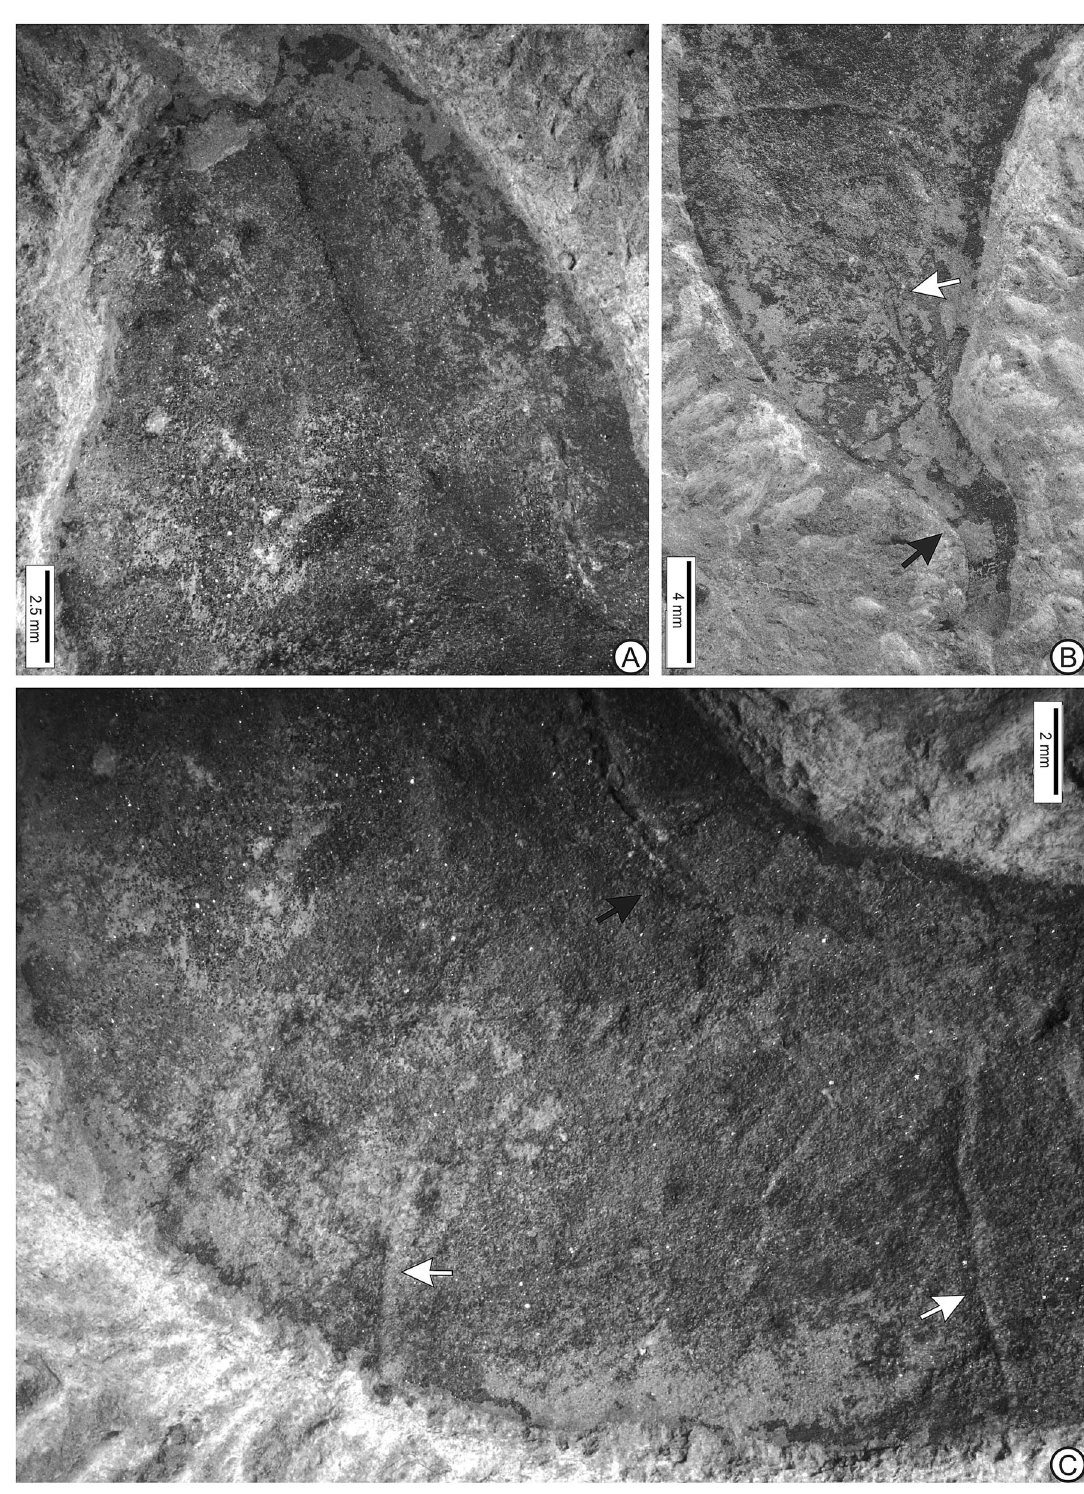
Fig. 3 Detail of the fossil sample, Holotype MUZ-3907. a Showing of the apex of fruit. b Base of the fruit, preserving reticulated veins (white arrow), and the stipe (black arrow). c Suture (black arrow), and fracture marks (white